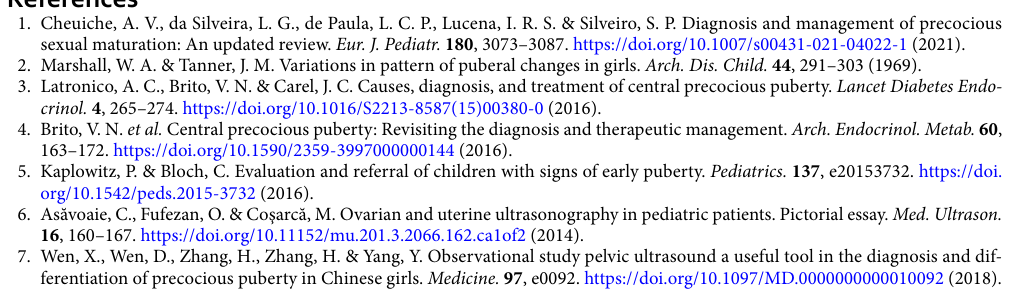
Doppler signal of the uterine arteries displayed three types of flow waves: —Type 1 (narrow systolic flow waves without diastolic flow) was observed in the majority of prepubertal girls, with a mean PI of 6.27 (range 3.5–8.0). —Type 2 (systolic flow waves with interrupted signal during diastole) was detected in five girls with Tanner breast score 1 and five girls with stages 2 or 3, with mean PI of 3.7 (range 2.5–5.0). —Type 3 (broad systolic flow waves with uninterrupted diastolic flow) was observed in post-menarche girls (n = 13) and in girls with Tanner breast stages 2 or 3 (n = 13), with mean PI of 2.0 (range 1.1–2.96). Negative correlation of PI with right ovarian volume, uterine transverse diameter, and uterine length was